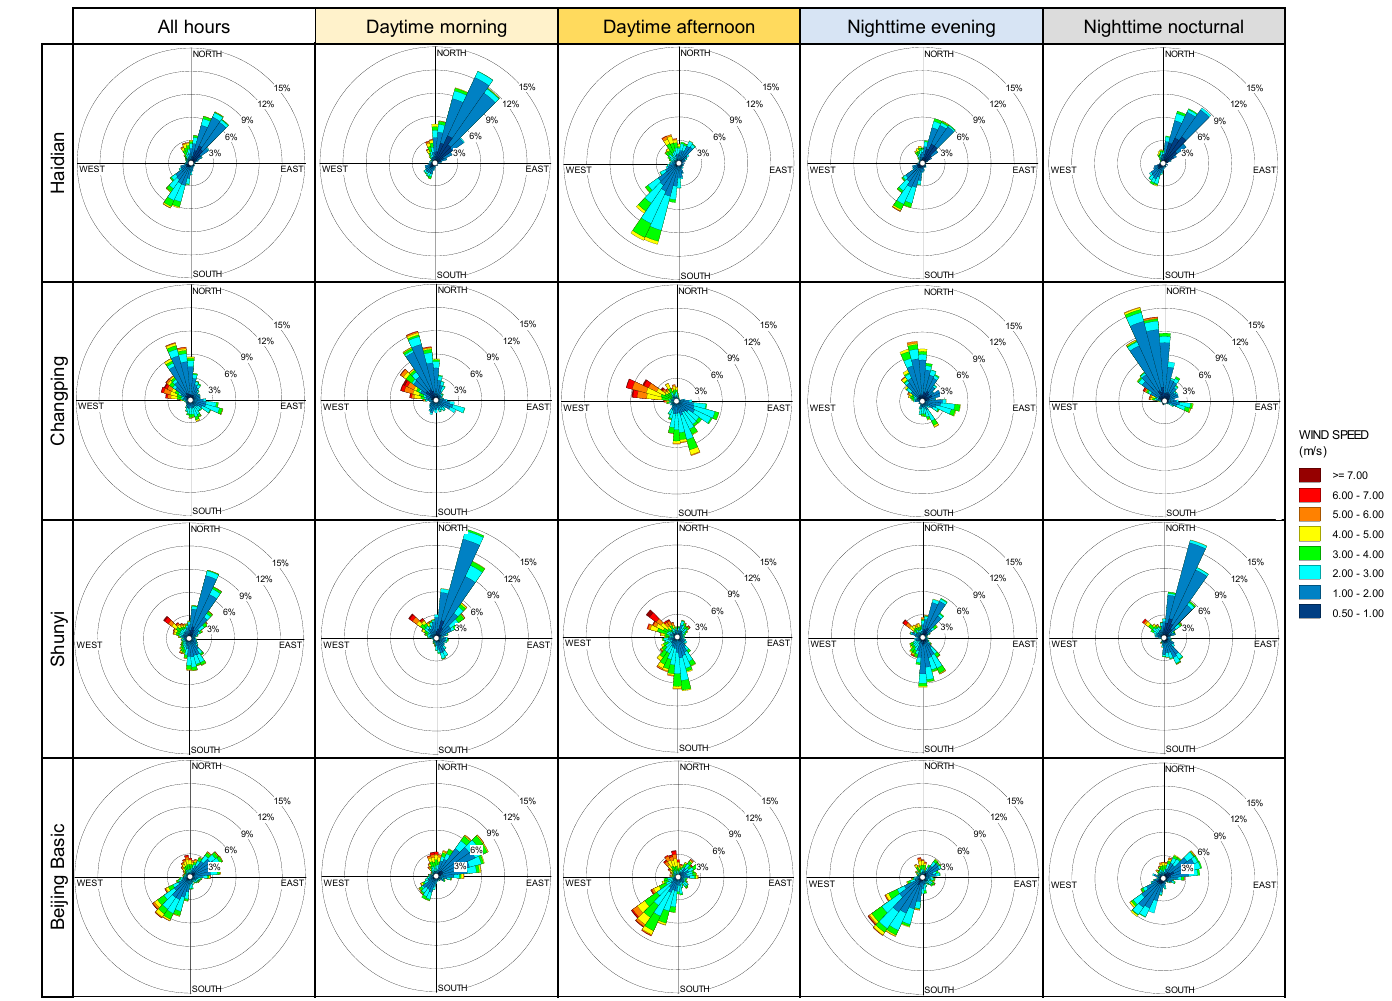
Figure 3. Station-specific wind roses for all hours of the day as well as for daytime and night-time (data period: 2017).